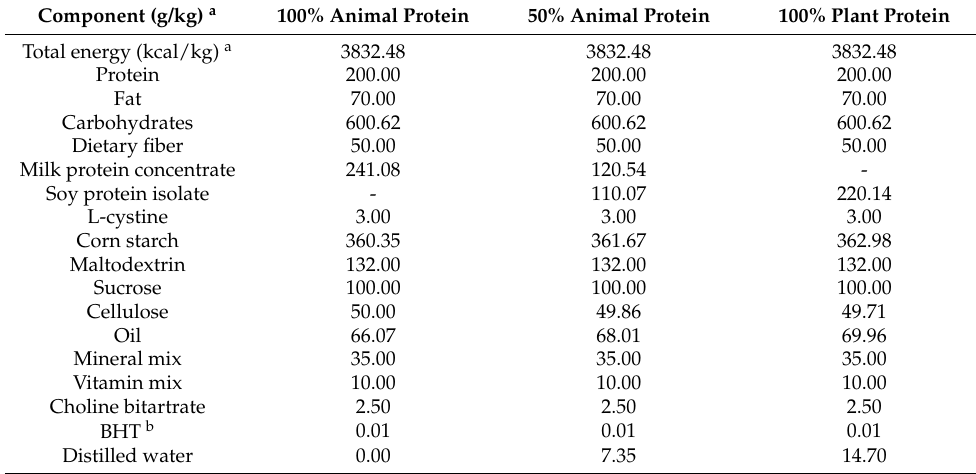
Table 1. Composition of the experimental